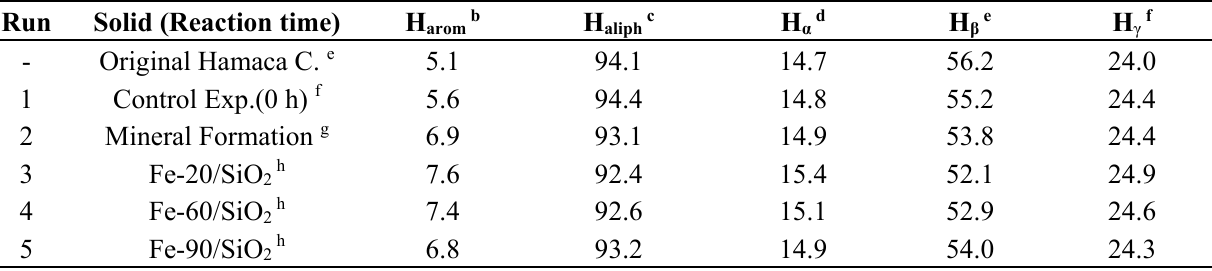
Figure 5. Mössbauer spectrum of Fe-20/SiO 2 catalyst after the upgrading experiment (315 °C, 24 h) with the continuous line representing the result of a computer adjustment including, IS (Isomer Shift), FWHM and QS (quadrupole splitting). Table 3. Protons distributions for upgraded Hamaca crude oils measured by 1 H NMR a . Effect of the Presence of Iron